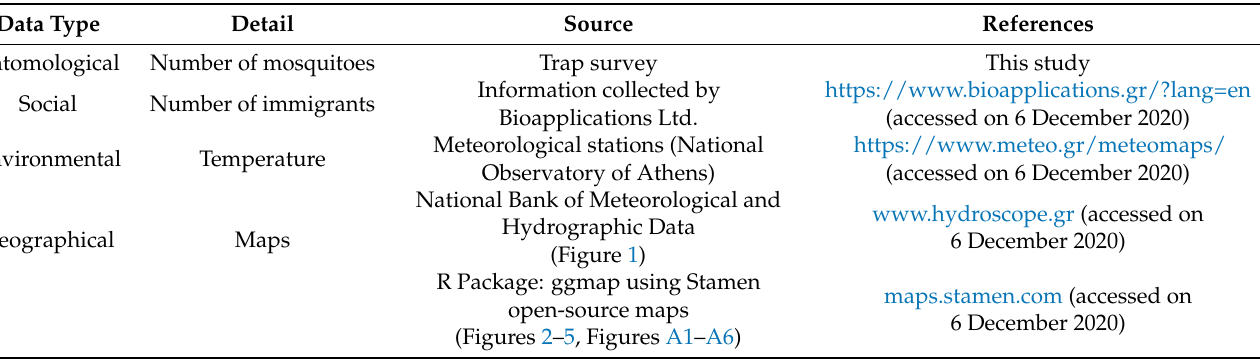
Table A2. Data used in the study.